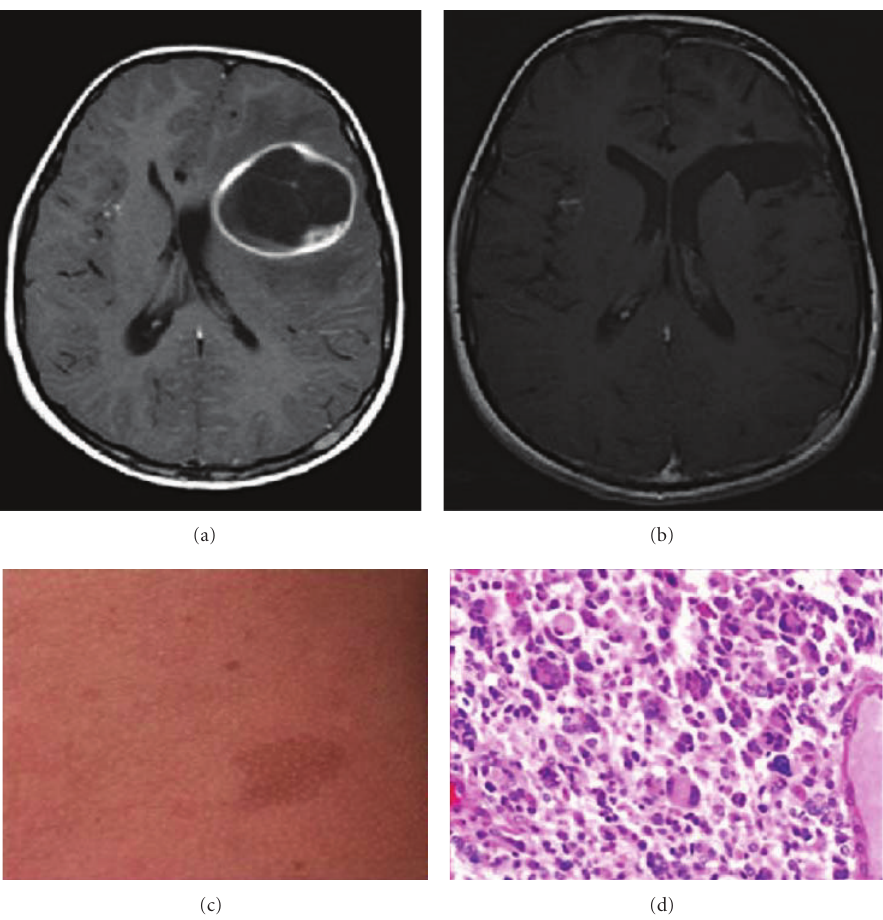
Figure 1: T1 axial MRI brain depicting left frontal tumor with rim enhancement associated with midline shift, (a) and after resection MRI brain demonstrates no residual tumor and a resolved mass e ff ect (b). Photograph of the patient skin caf´e-au-lait spots (c). (d) Histopathology shows high mitotic index and multinucleated giant cells representing GBM features. Hematoxylin and eosin stain 5